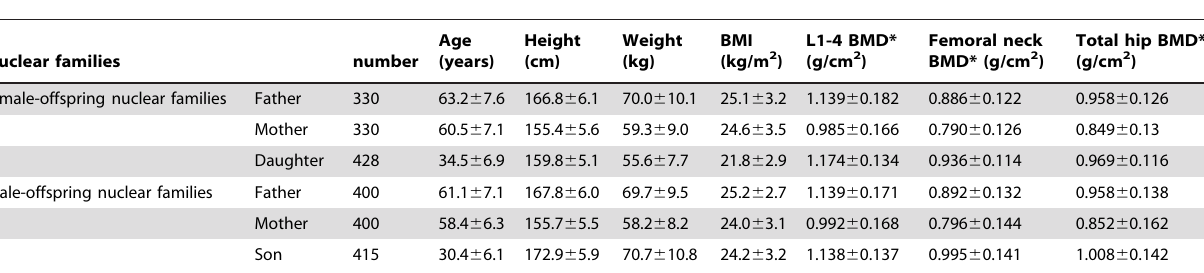
Table 1. Basic clinical characteristics of the parents and adult offspring from 730 nuclear families.